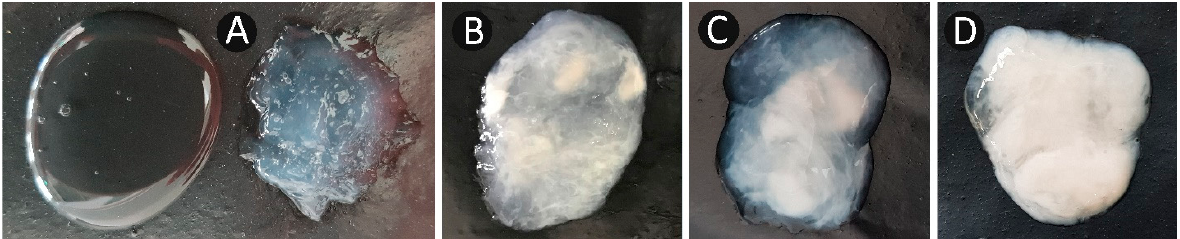
Figure 1. ( A – D ) Uterine discharges from female dromedary camels; ( A ) clear/mucoid gelatinous discharge without pus (right) and translucent rectal examination gel (left); ( B ) mucoid discharge with specks of pus < 25% (PGD1); ( C ) purulent discharge with 25–75% pus (PGD2); ( D ) purulent discharge with >75% pus